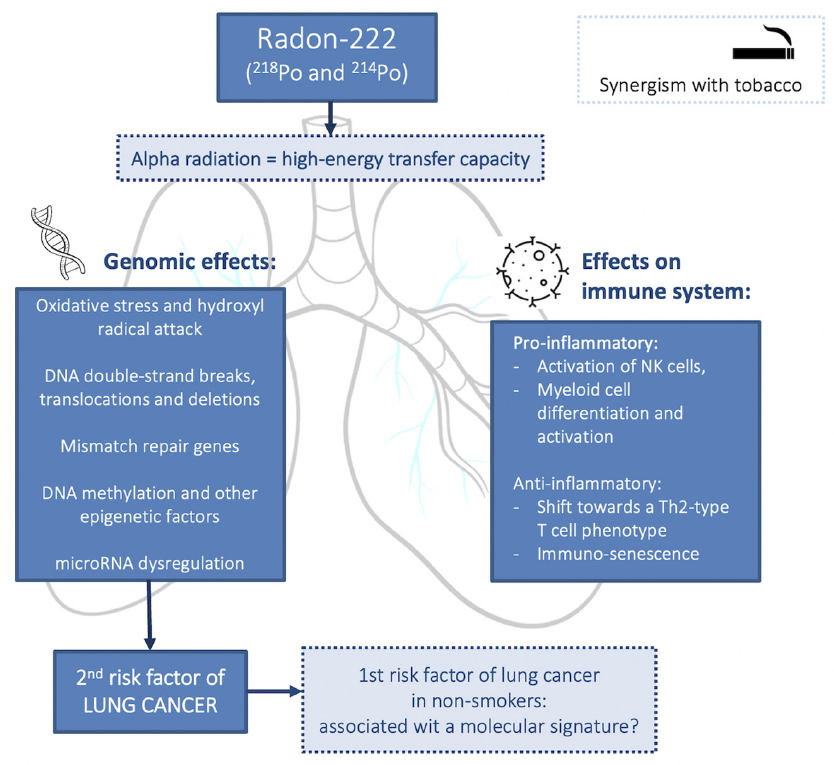
Figure 2. Radon-described mechanisms of carcinogenesis in lung cancer.